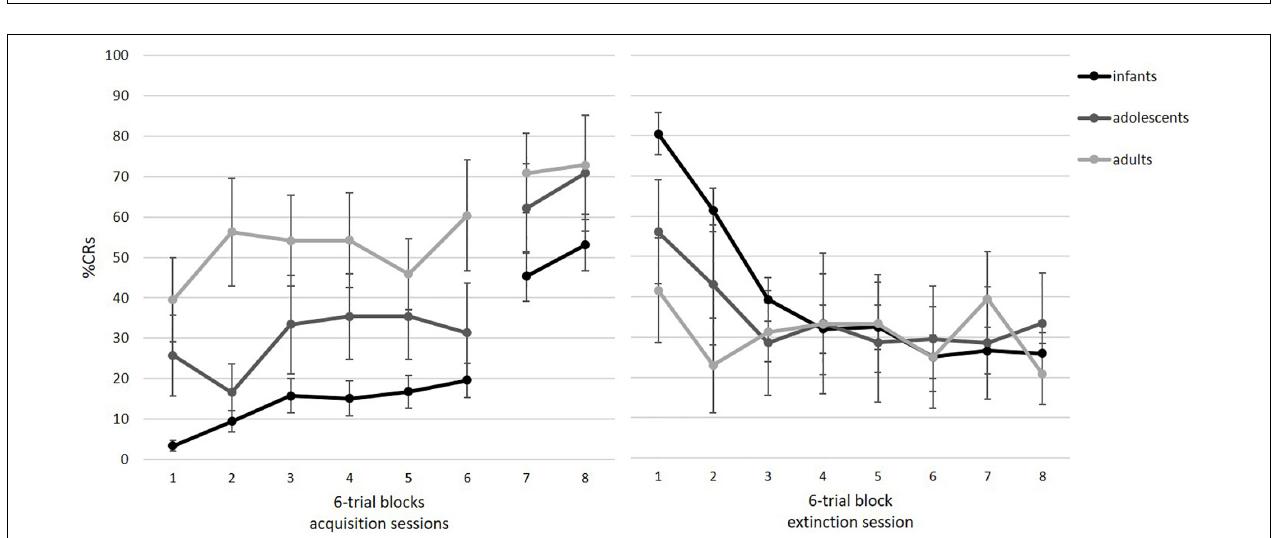
FIGURE 4 | Results of the feasibility questionnaire filled out by parents after session 1 as a function of completers and non-completers. N = 42 parents of completers provided answers for all items, except for negative feelings where only 41 parents provided answers. One parent of a completer did not provide any information. N = 29 parents of completers provided answers for the child items, and 28 parents of completers provided answers for the parent items. The scale ranges from 10 (very high) to 0 (very low). Error bars are SE of M.